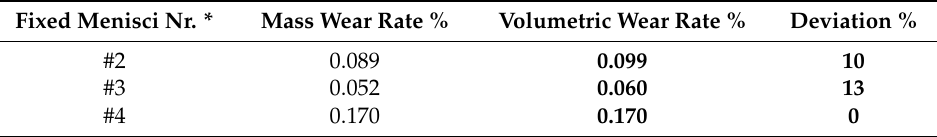
Table 2. Wear rates comparison at the end of the wear test. Fixed Menisci Nr. *